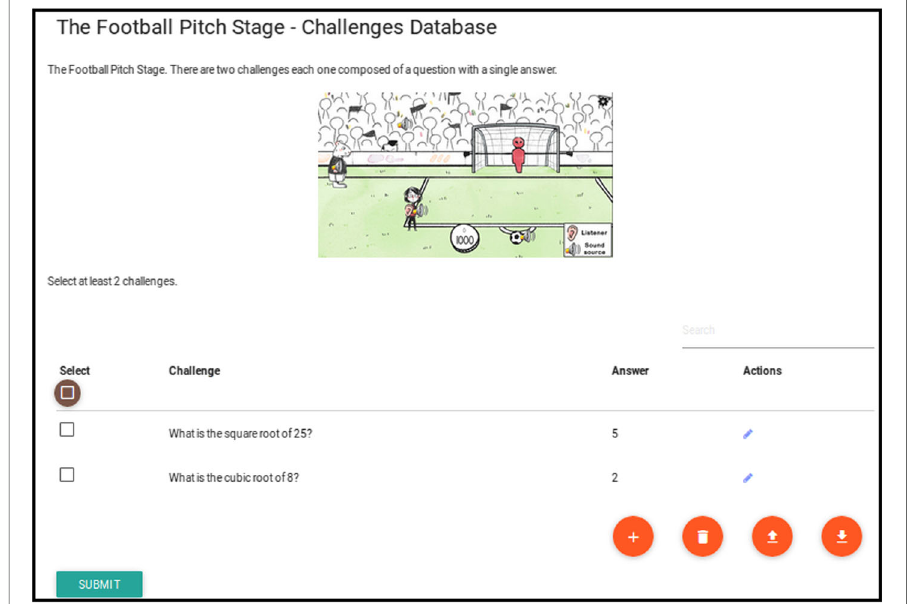
Fig. 3 Football Pitch: challenges customisation through REMAR